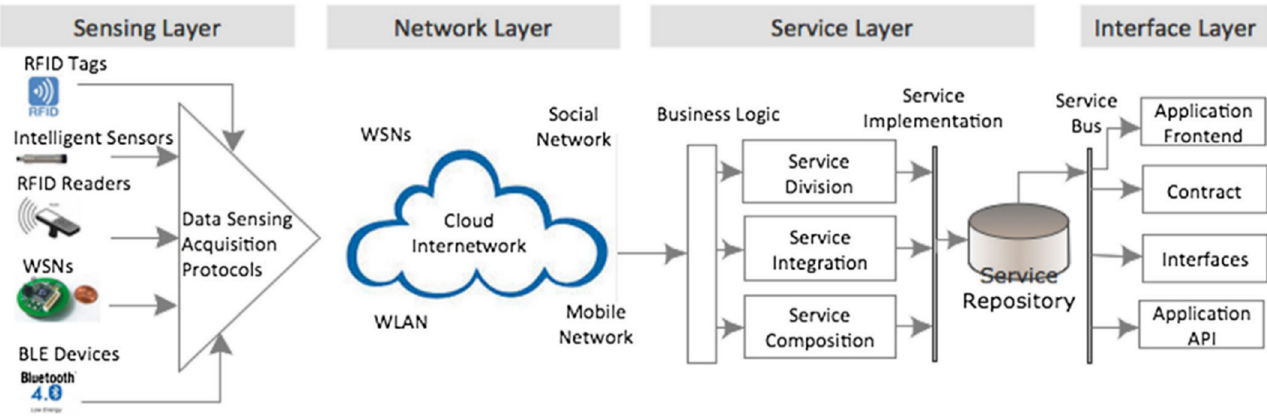
Figure 11. IoT service-oriented architecture [86].